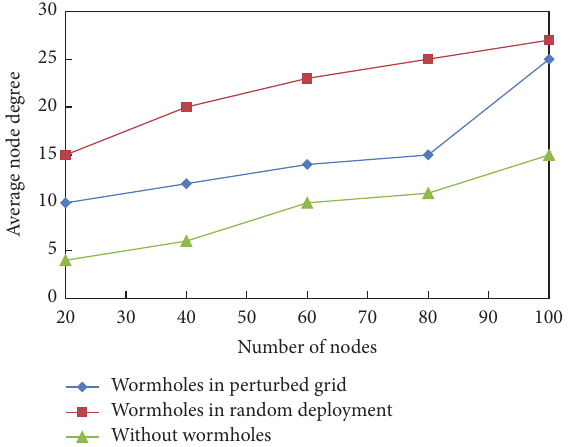
Figure 7: Effect of wormholes on average node degree.